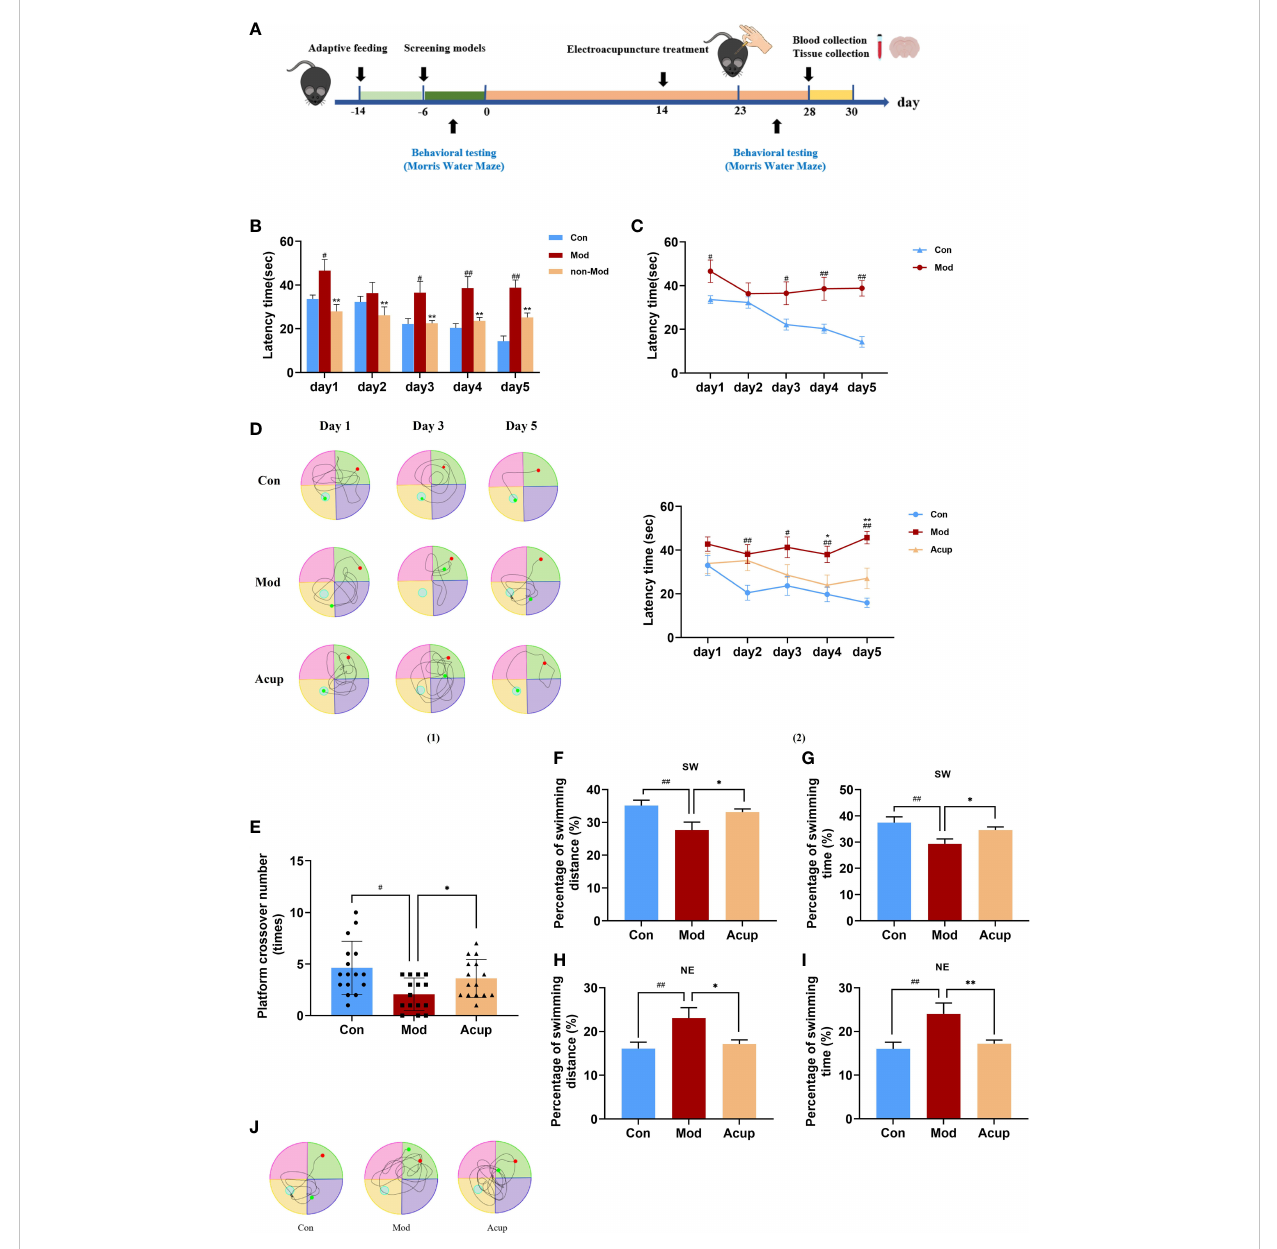
FIGURE 1 Electroacupuncture improves db/db mice ’ s learning and memory abilities of the MWM test, respectively. (A) Timeline of experimental procedures. (B, C) A comparison of escape latency in each group from day 1 to day 5 before treatment. (D) A comparison of escape latency in each group from day 1 to day 5 after treatment. (E) A comparison of passing times in each group through the platform quadrant on the sixth day. (F) A comparison of percentage of swimming distance in each group through the platform quadrant (SW) on the sixth day. (G) A comparison of percentage of swimming time in each group through the platform quadrant (SW) on the sixth day. (H) A comparison of percentage of swimming distance in each group through the entry quadrant (NE) on the sixth day. (I) A comparison of percentage of swimming time in each group through the entry quadrant (NE) on the sixth day. (J) The swimming track in each group on the sixth day in 60 s. Non-Mod represents db/db mice model without cognitive impairment. Data are expressed as means ± SEM. Mod vs Con, # p < 0.05, ## p < 0.01; Acup vs Mod, * p < 0.05, ** p <